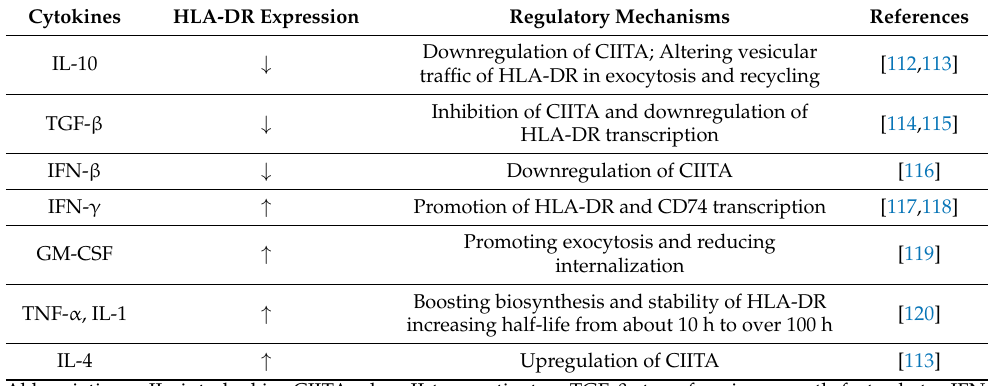
Table 1. Cytokine Modulation of HLA-DR Expression.